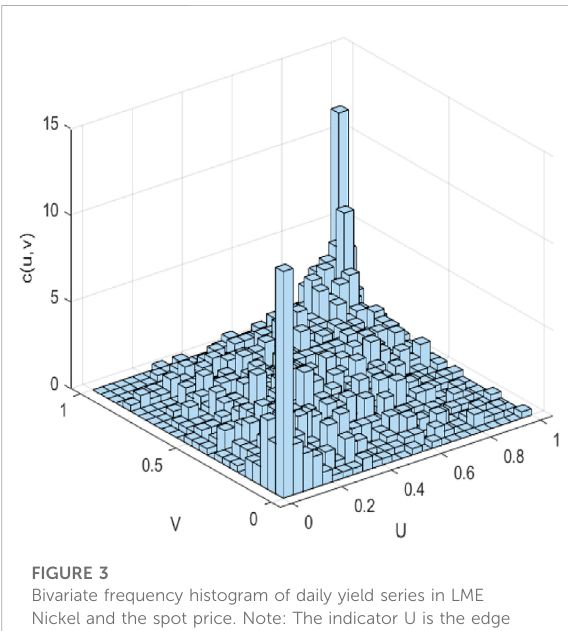
FIGURE 3 Bivariate frequency histogram of daily yield series in LME Nickel and the spot price. Note: The indicator U is the edge distribution of LME Nickel futures. The indicator V is the edge distribution of the spot price. C (U,V) represents a joint distribution